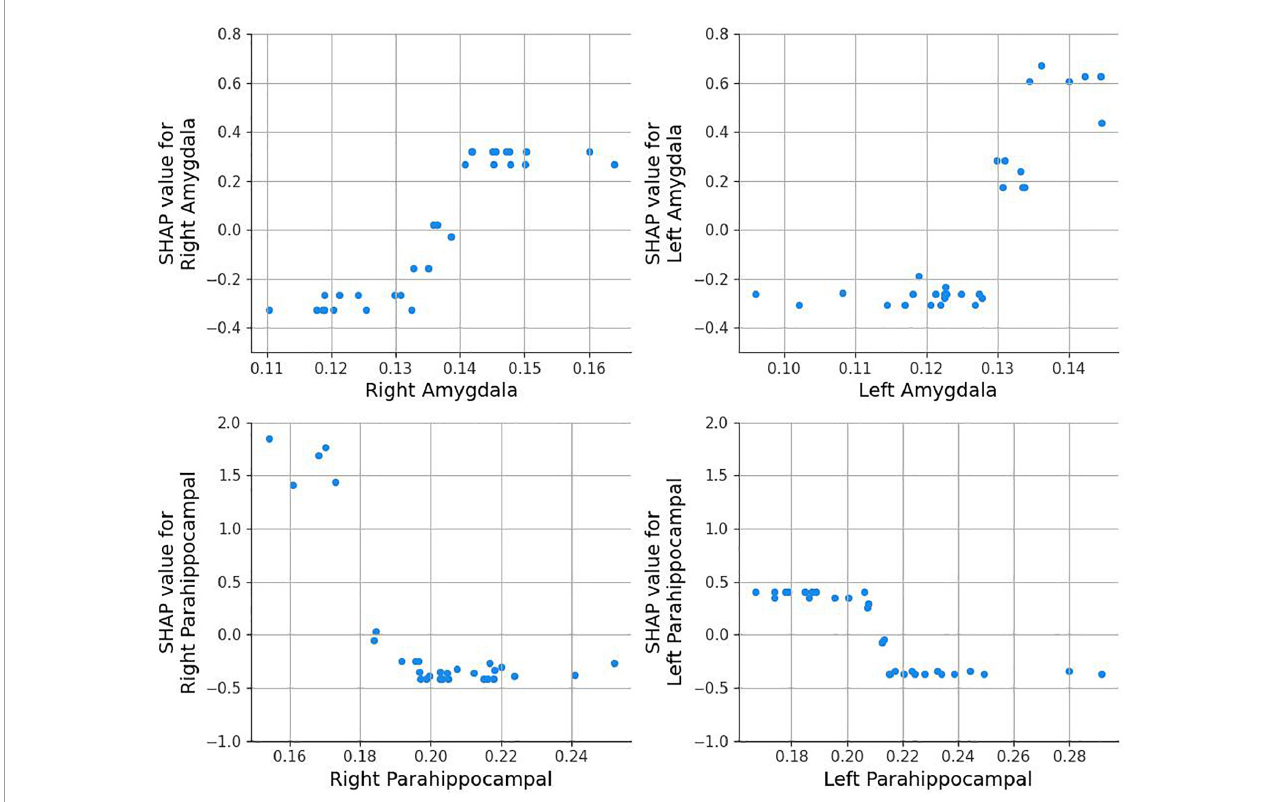
FIGURE5 Amygdala and parahippocampal dependence plots. A higher SHAP value indicates that the model is more likely to predict 1 (Sandy exposure).